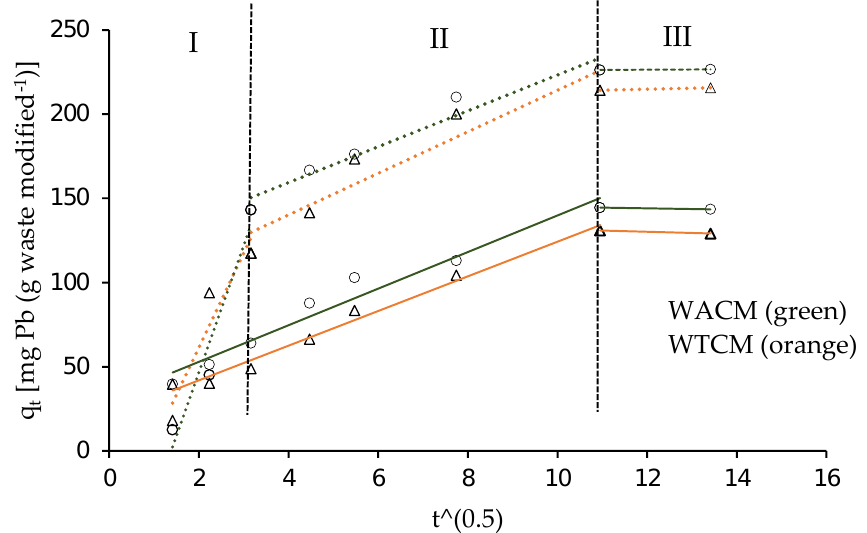
Table 4. Kinetic parameters of Pb(II) adsorption on WACM and WTCM biosorbents.